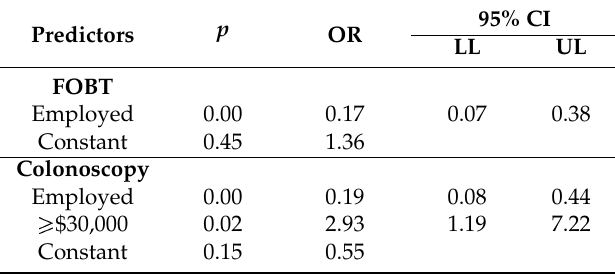
Table 3. Multiple logistic regression model for colorectal cancer screening